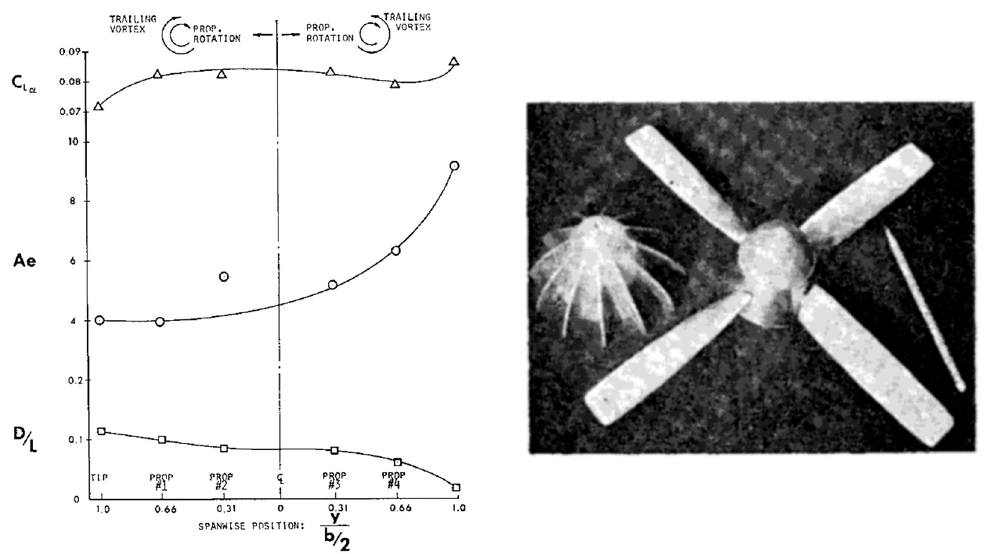
Figure 19. Effect of propeller position on wing characteristics. Reproduced with permission from Ref. [72] 1964 American Institute of Aeronautics and Astronautics.